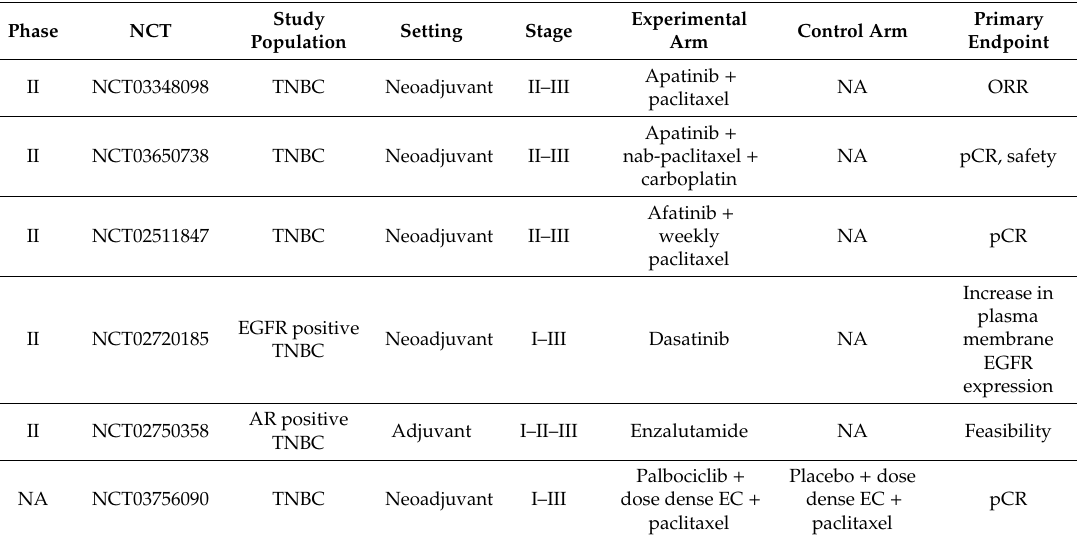
Table 4. Ongoing (neo)-adjuvant clinical trials with potential therapeutic